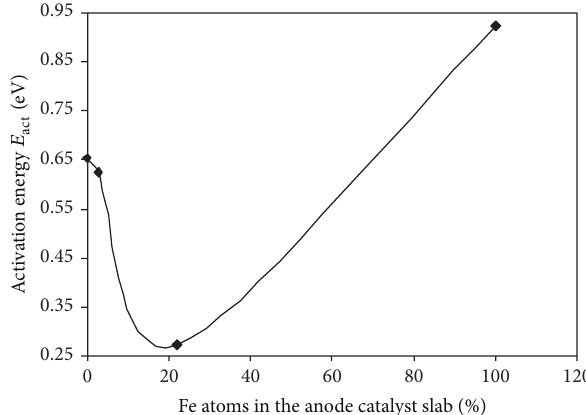
Figure 7: Energies of the adsorbate plus slab where the central carbon atom of the adsorbate had a defined C–H bond length. All the other bond lengths and all the bond angles in the adsorbate were permitted to relax to those values that produced the minimum energy.